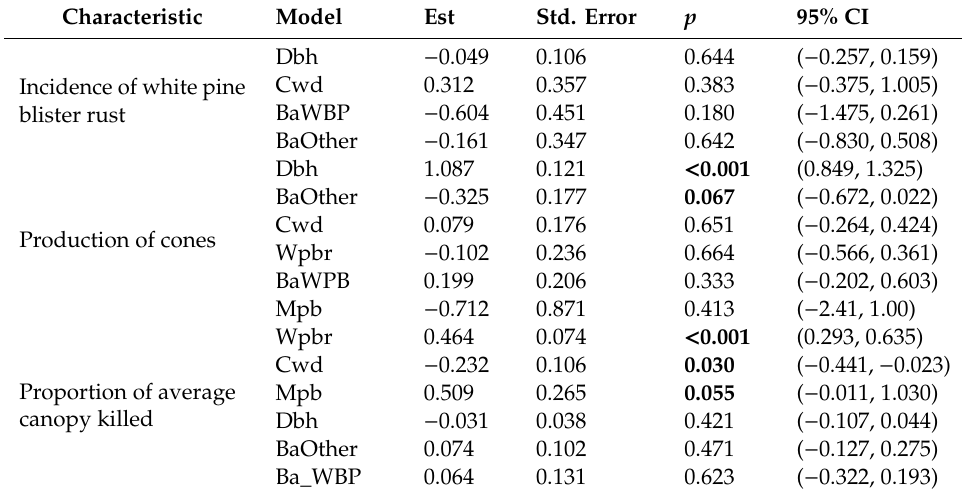
Table 5. Estimated e ff ects of site characteristics from the Generalized Linear Mixed Model (GLMM) of the probability of producing cones (no = 0, yes = 1), probability of blister rust infection (uninfected = 0, infected = 1), the probability of mountain pine beetle infestation (uninfested = 0, infested = 1), and the proportion of average canopy in Lassen Volcanic National Park. p -values indicate the significance of the Wald Z -test statistic. Characteristic Model Est Std.